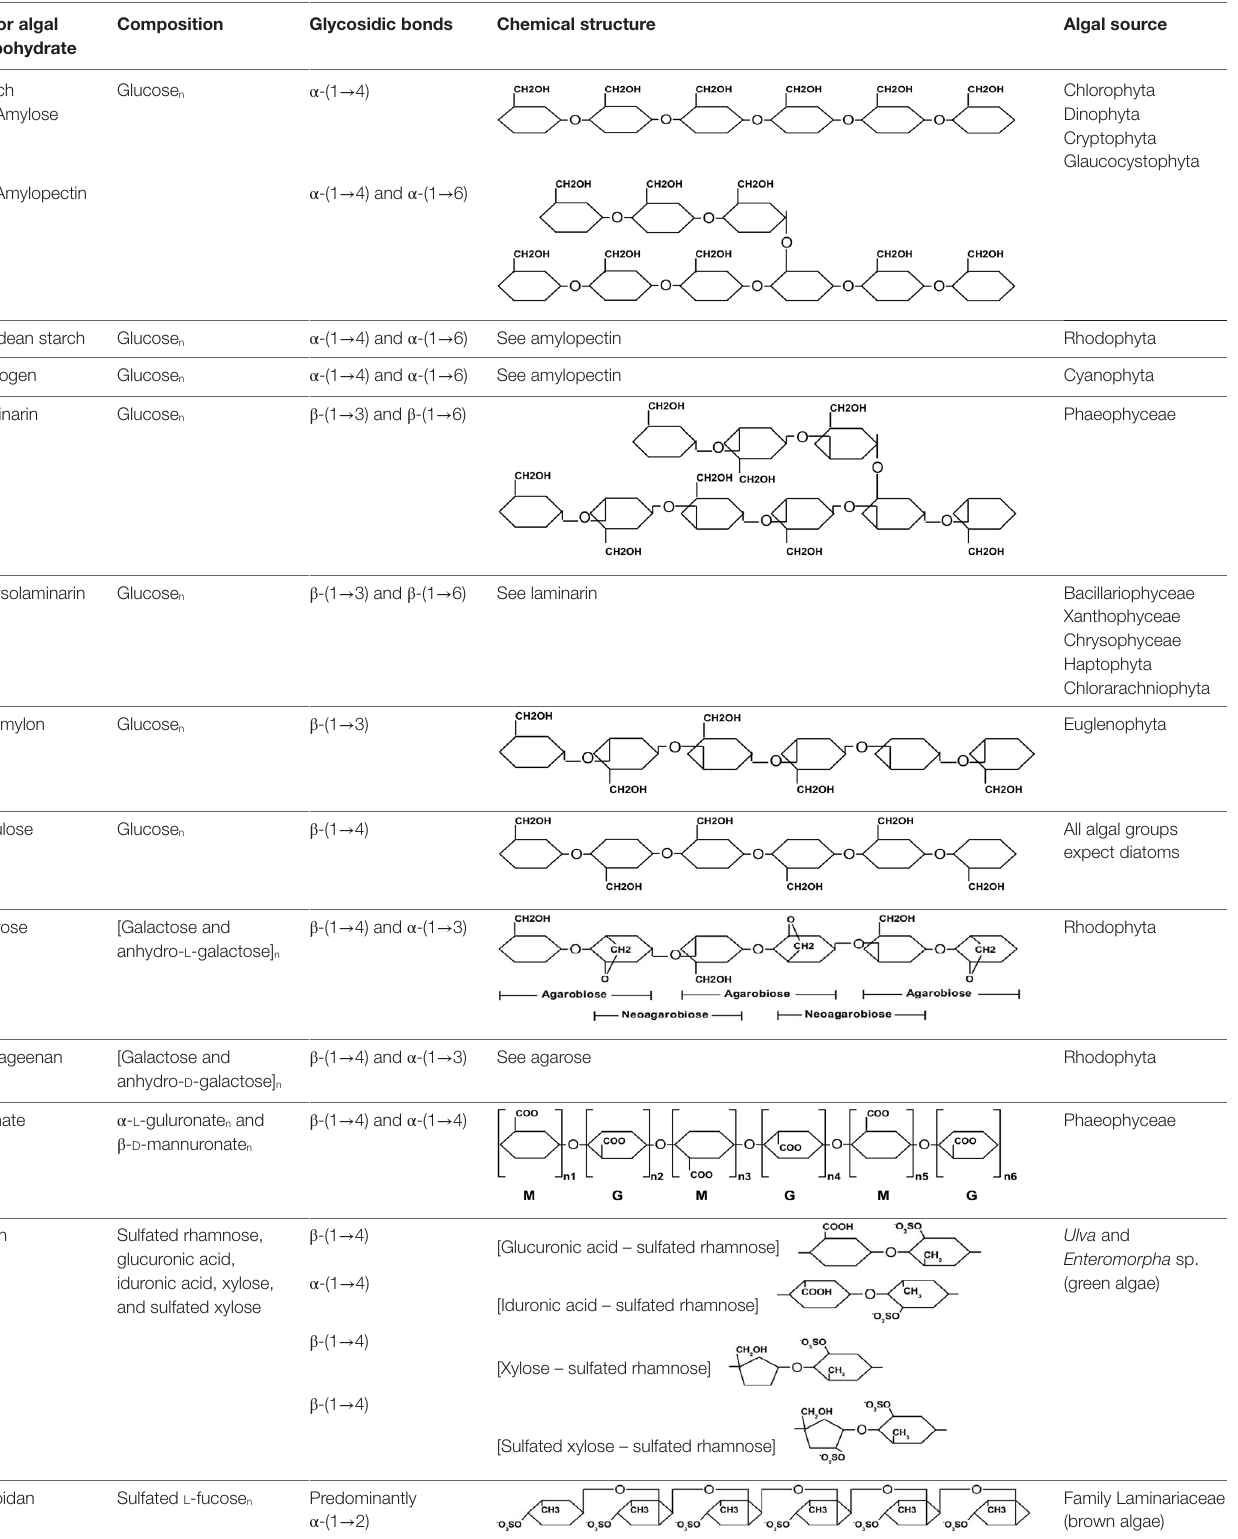
TABLe 2 | Chemical structure and distribution of food reserves and structural polysaccharides among different groups of